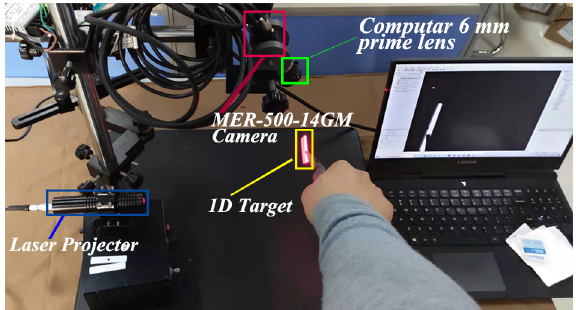
Figure 6. The apparatus used for the